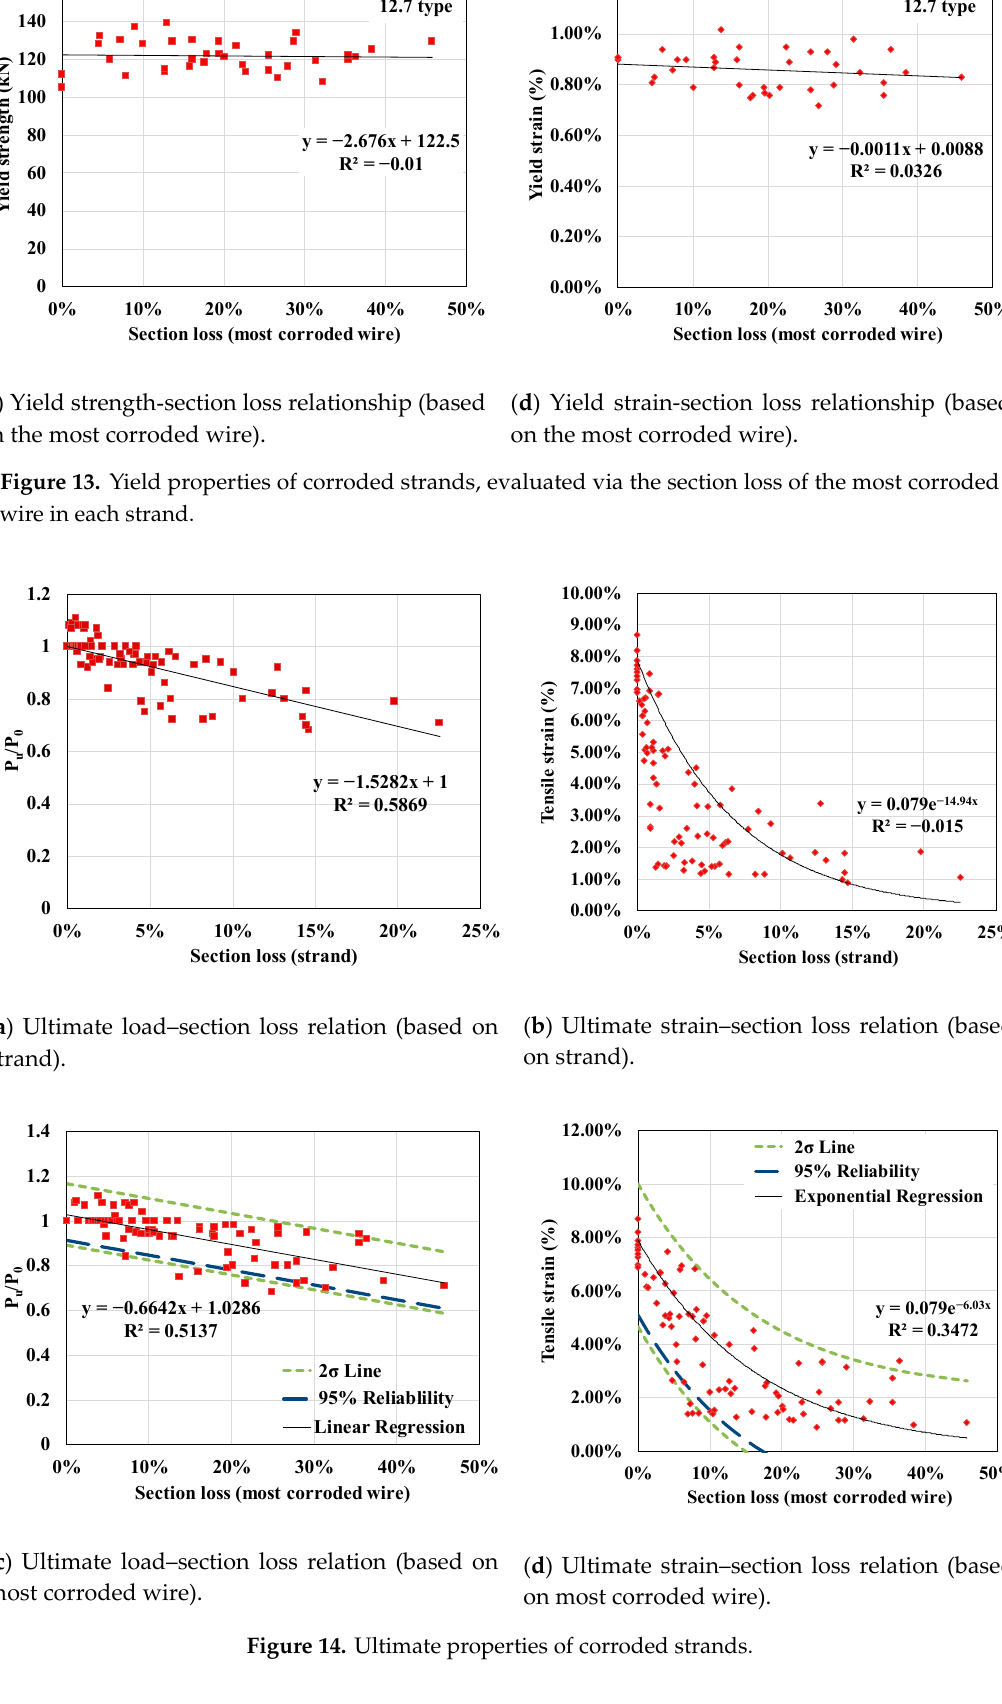
Figure 14. Ultimate properties of corroded strands.